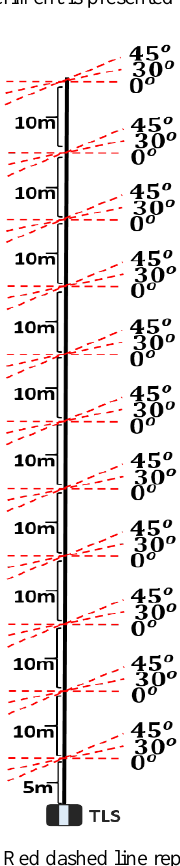
where 𝐴, 𝐵, 𝐶 and 𝐷 represent plane coefficients and (𝑥,𝑦, 𝑧) represents the point which lies on the plane. After computation of coefficients, the distance between each 𝑖 𝑡ℎ point of the coated glass and Least Square Plane was computed using Equation 10.